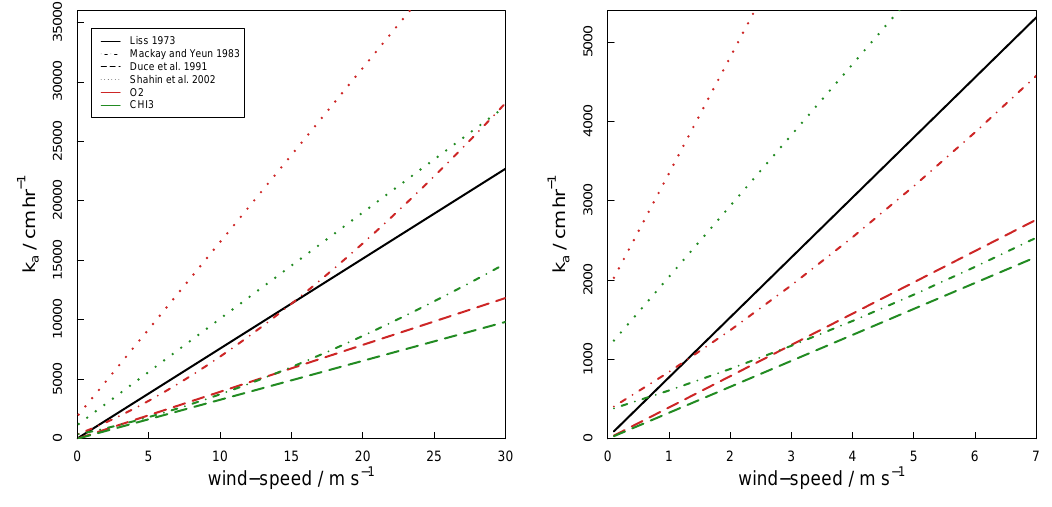
Fig. 1. Comparison of different parameterizations of k a , the air-side transfer velocity (Eqs. 6 to 9) for O 2 and CHI 3 , calculated at 15 ◦ C, where applicable. Note that the parameterization of Liss (1973) (black line), is neither temperature nor gas specific. For this and subsequent transfer velocity figures (Figs. 2 – 5) the right-hand panel reproduces the 0–7m/s wind speed section of the left-hand